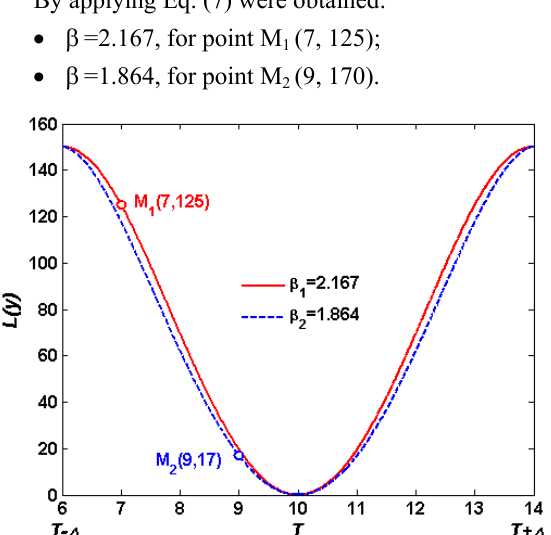
Figure 6. Influence of secondary points on the form of PLF curve points. In this case, as could be expected, an